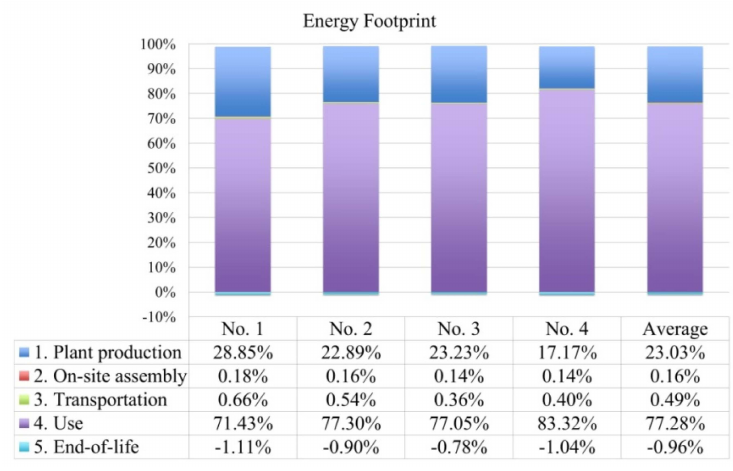
Figure 3. Contributions of the five LCA phases to the energy footprint of the four selected